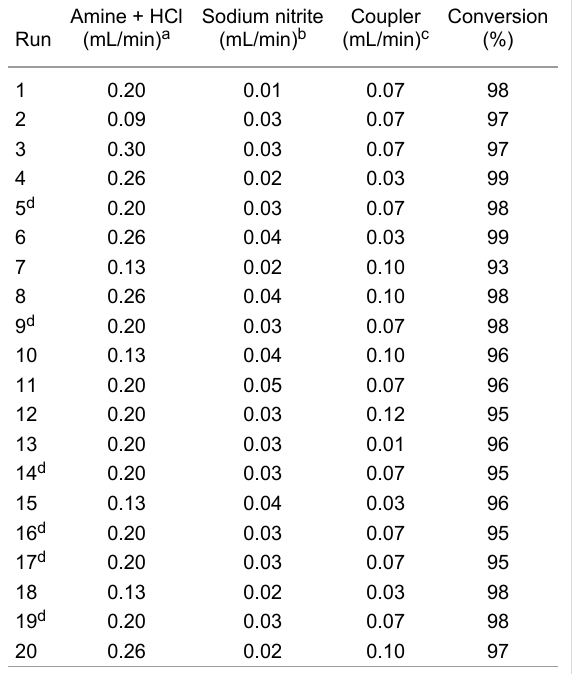
Table 5: Data showing conversions attained at various reaction condi- tions. Amine + HCl Run (mL/min) a